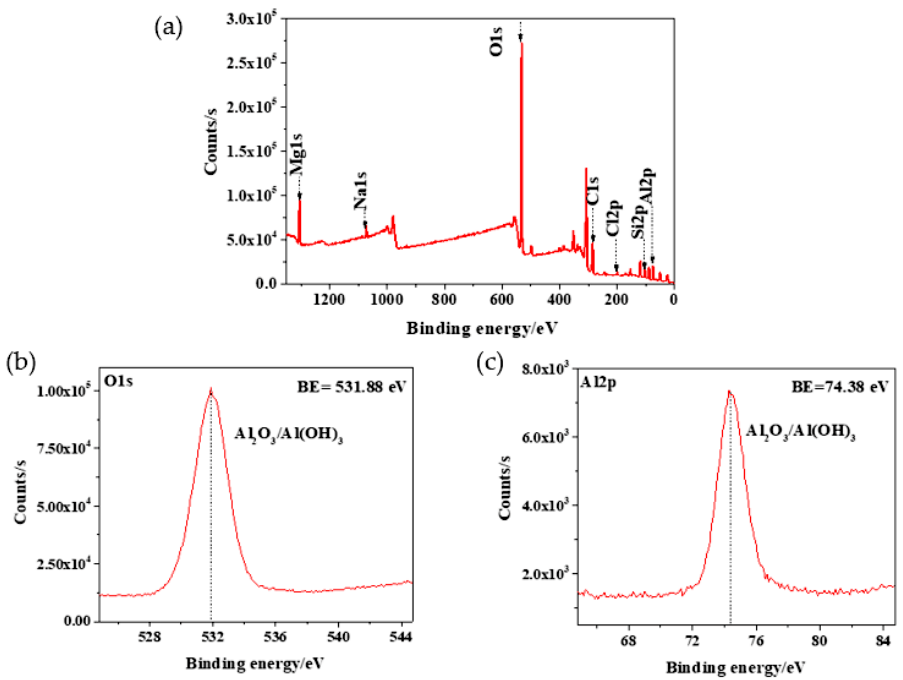
Figure 5. Overview XPS spectra acquired from AA6061-T6 after 30 days of immersion in Caribbean seawater with laminar flow: ( a ) full spectrum; ( b ) and ( c ) spectrum for O1s and Al2p, respectively.